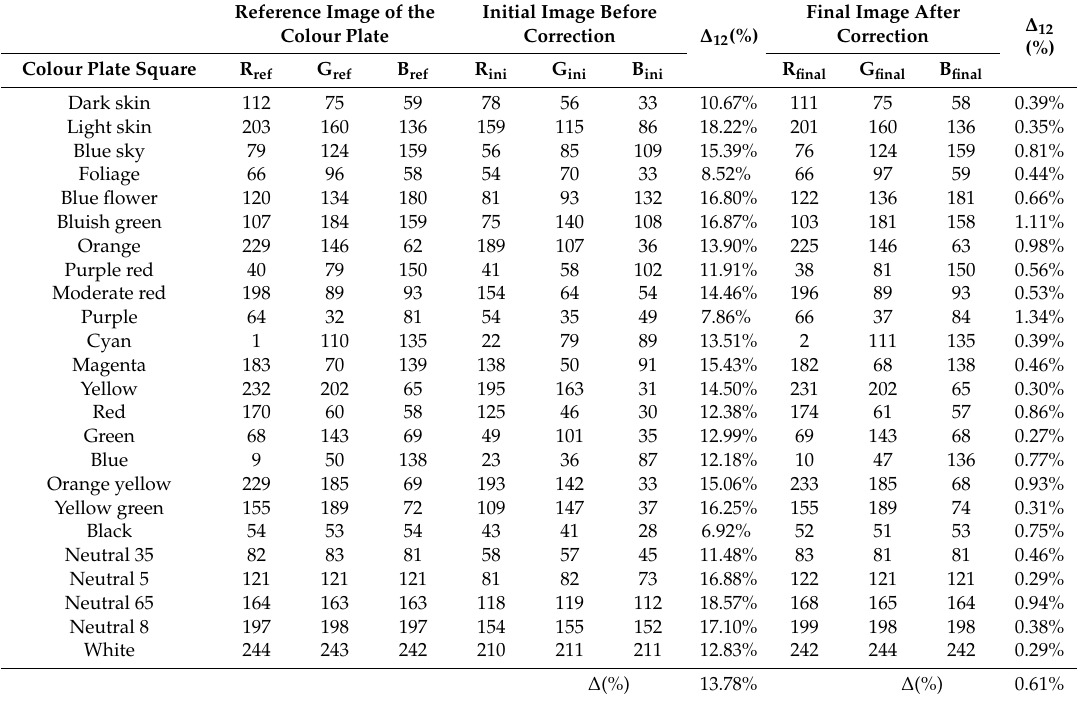
Table A2. RGB values of the colour square of the colour plate on the reference image in Figure A5b and on the initial and final image to correct in Figure A5c,h, respectively. The average value of ∆ between the image to correct and the reference image is 13.78% before correction and only 0.61% after CaliPhoto